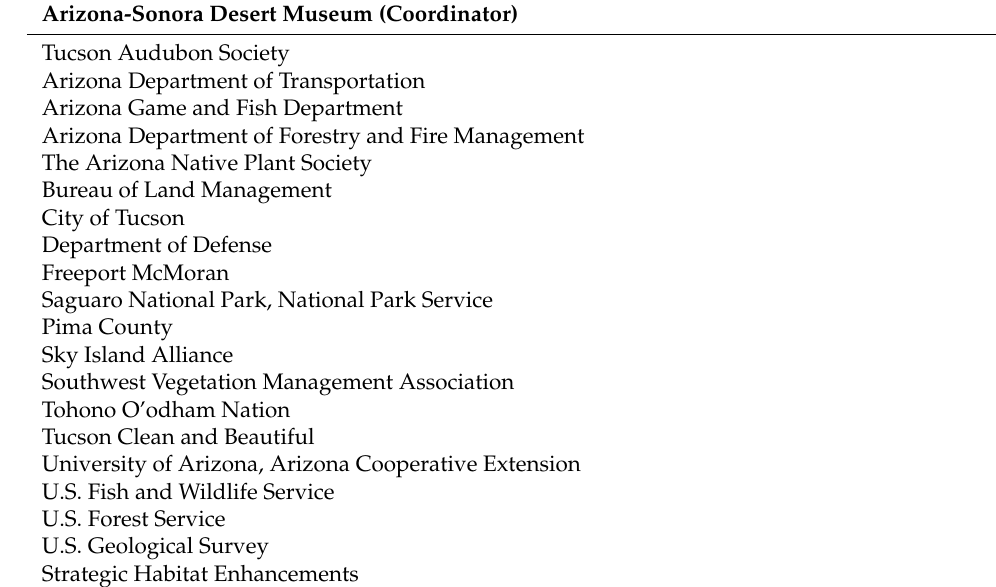
Table 1. Partners in the Sonoran Desert Cooperative Weed Management